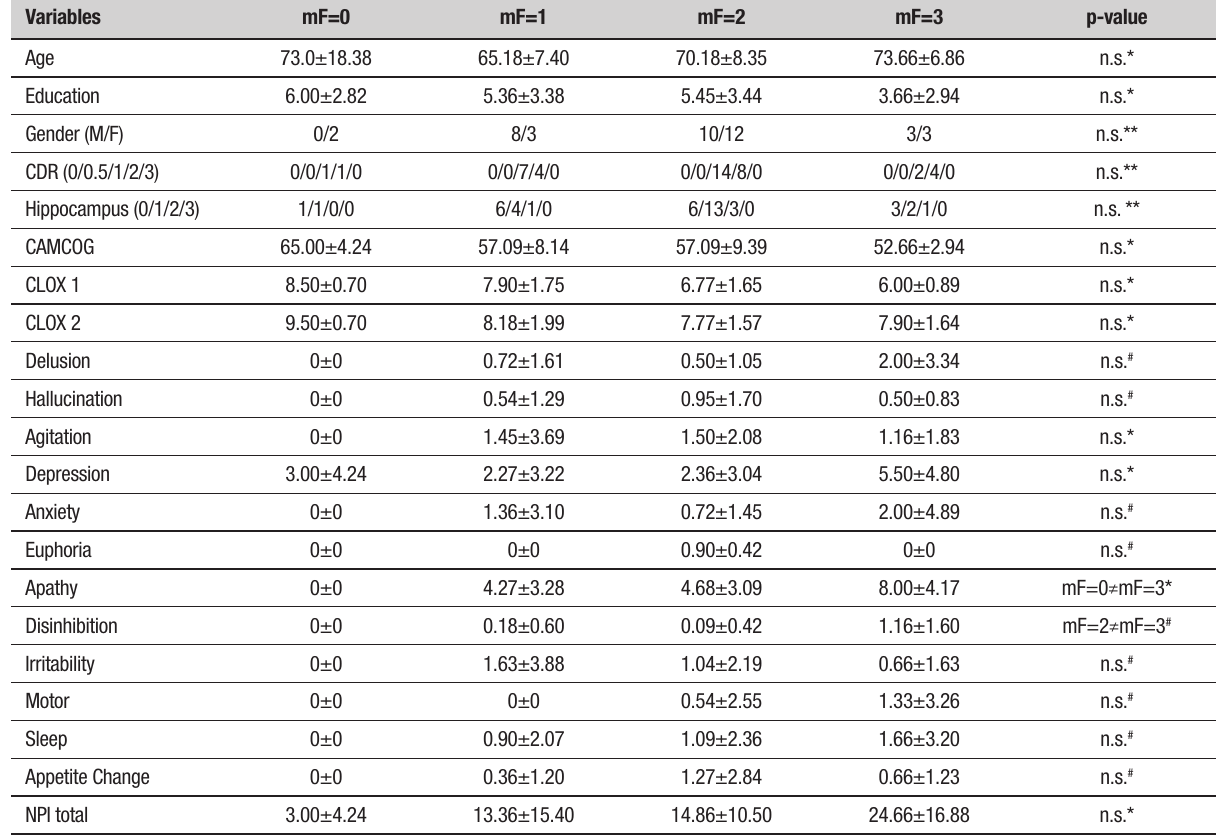
Table 3. Sociodemographic, clinical/cognitive and NPI staging score data. Variables